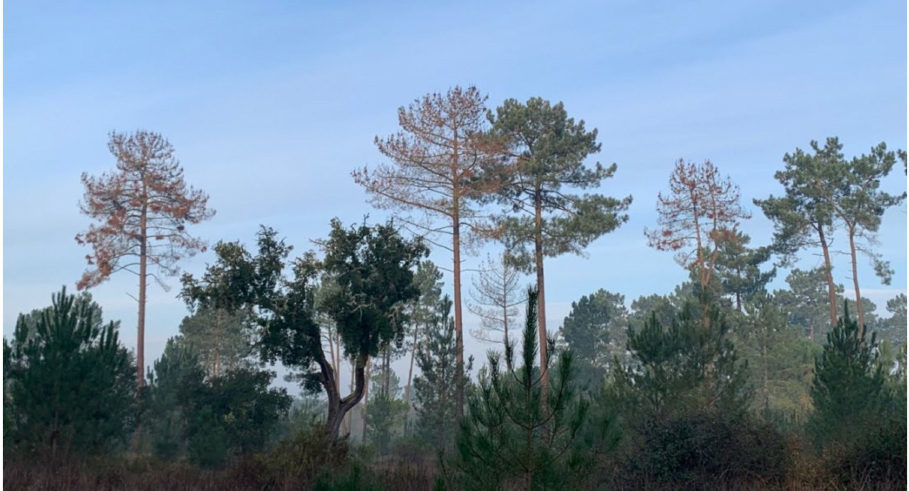
Figure 2. Symptoms of Pine Wilt Disease—wilted Pinus pinaster trees (pine trees with brown canopy) surrounded by assymptomatic P. pinaster (greenish canopy without PWD manifestation). Location: Companhia das Lez í rias (Portugal; 38 ◦ 49 (cid:48) 17.6 (cid:48)(cid:48) N 8 ◦ 52 (cid:48) 20.5 (cid:48)(cid:48) W), in January